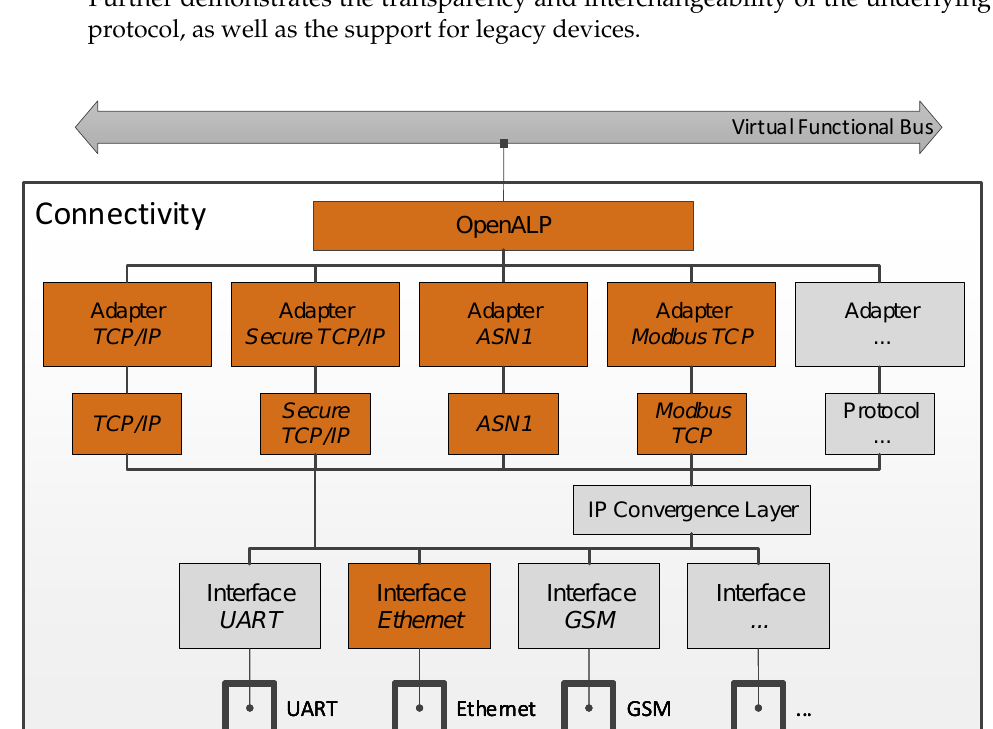
Figure 15. Connectivity module parts tested in scenario “Generic and Interoperable Communication” (adopted from Reference